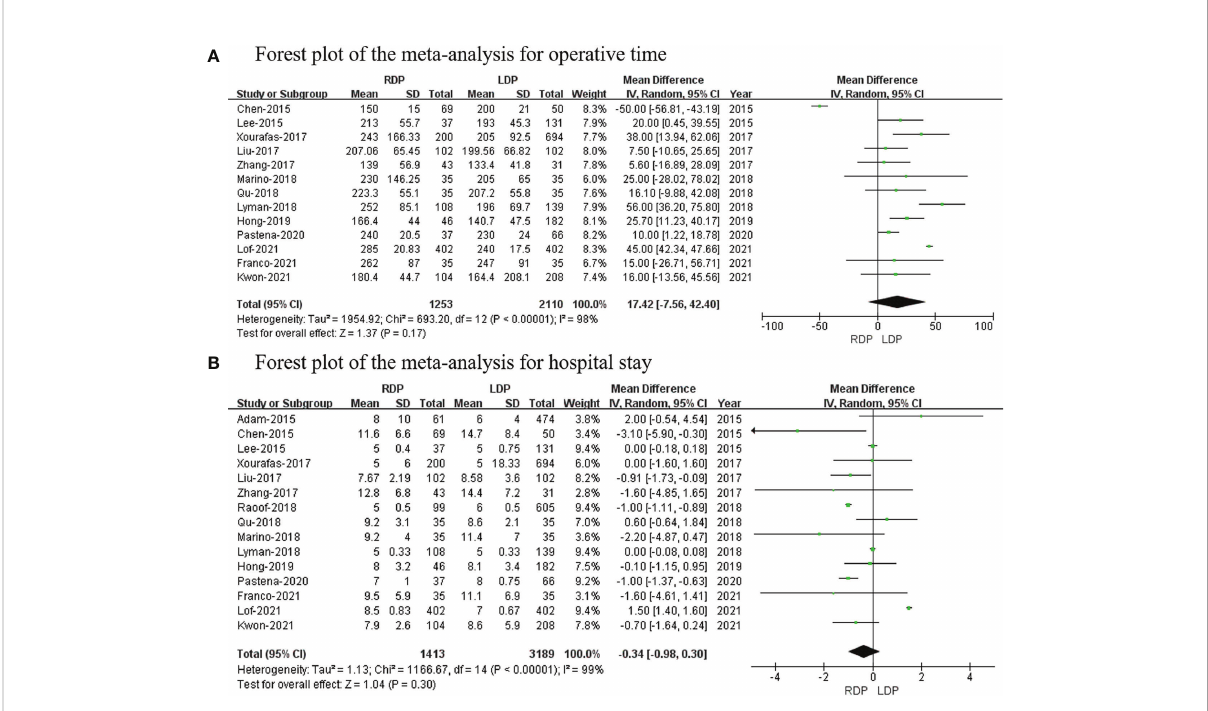
FIGURE 2 Forest plot of the meta-analysis for (A) operative time and (B) hospital